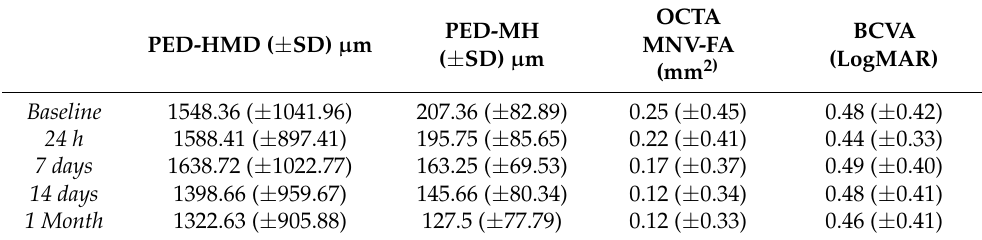
Table 2. Characteristics of structural OCT and OCT-A at baseline, after 24 h, at 7 days, at 14 days and 1 month after the Brolucizumab